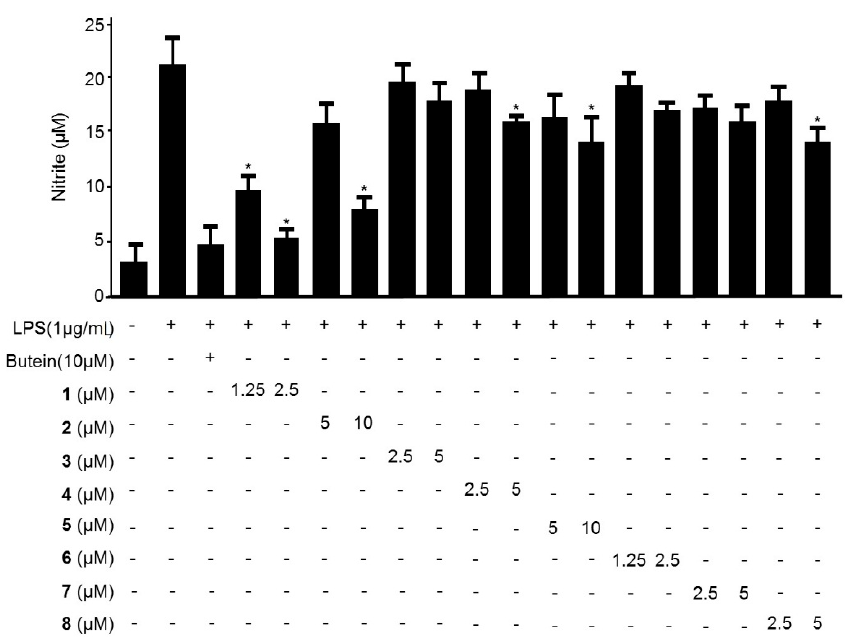
Figure 2. The effects of compounds 1 – 9 on NO production in BV2 microglia stimulated with LPS. The cells were pretreated for 3 h with the indicated concentrations of compounds 1 – 9 and stimulated for 24 h with LPS (1 µg/mL). The LPS treatment was performed in the presence of compound. The concentrations of nitrite were determined as described in the Experimental Section. The data show the means ± SDs of three experiments. * p < 0.05 compared with the group treated with LPS. “+” is treated, “ − “ is not